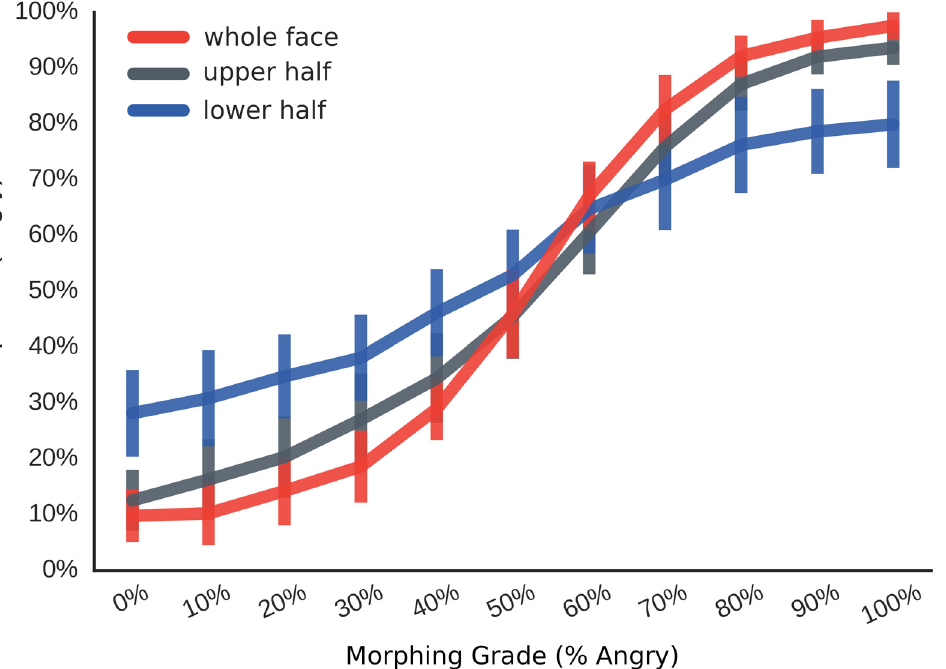
Fig 2. Main Results Experiment 1. Percent angry responses (y-axis) across the 11 morphing grades morphed from fear to anger (x-axis) for the three different visibility conditions (coloured lines); 'whole face', whole face is visible (no masking); 'lower half', lower face half is visible (upper half is masked); ‘ upper half', upper face half is visible (lower half is